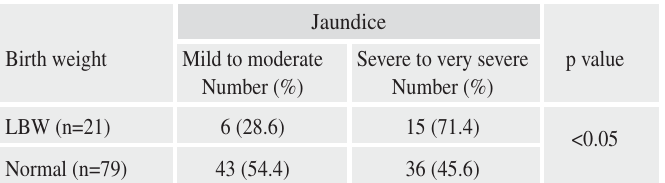
Table V: Association between birth weight and severity of